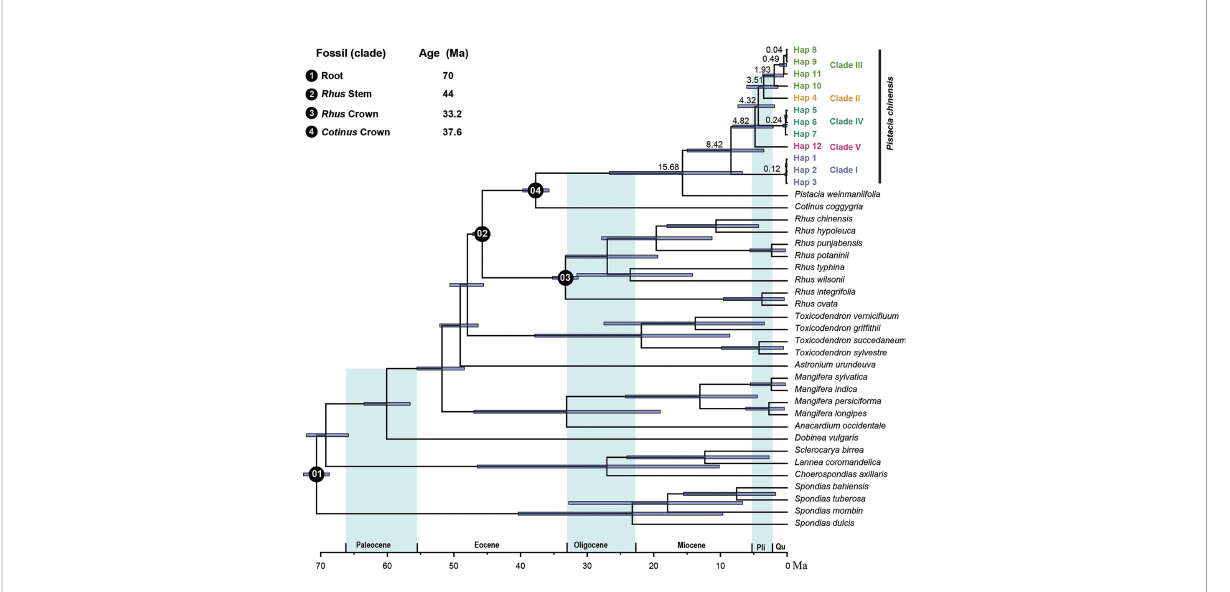
FIGURE 6 Divergence time of Anacardiaceae. The mean divergence time of the nodes is shown next to the nodes, and the blue bars correspond to the 95% highest posterior density